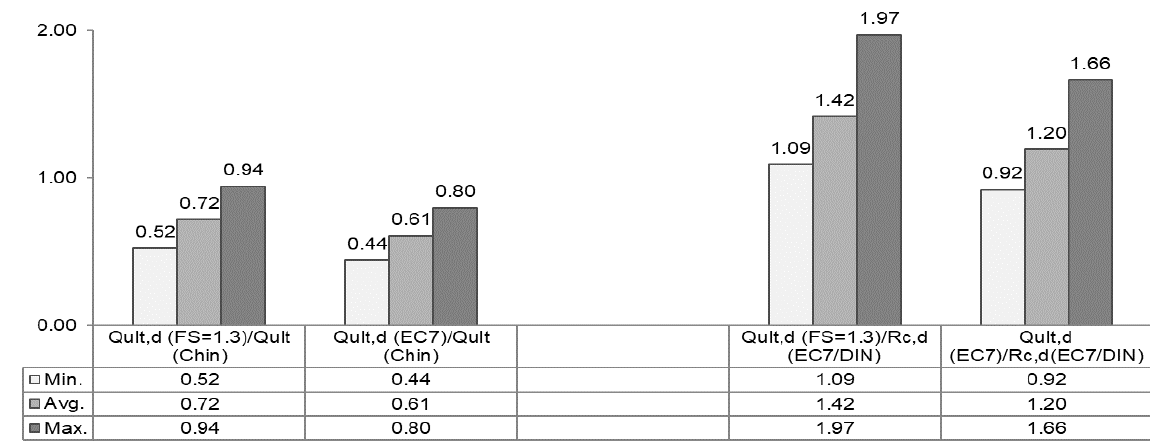
Figure 15: Summary of ultimate bearing capacity values from diverse design